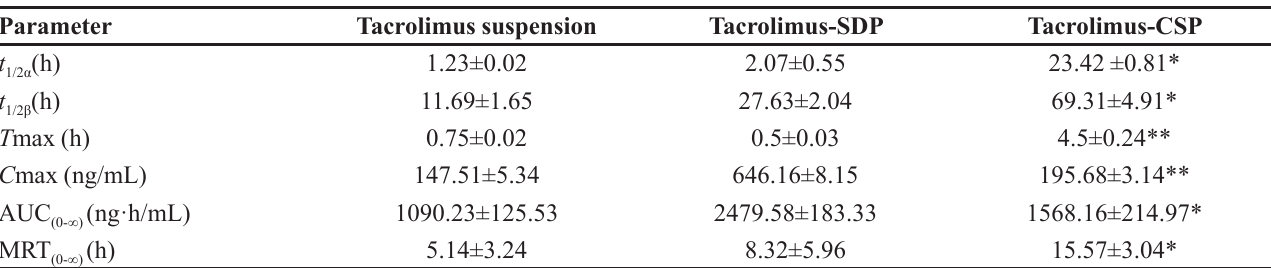
FIGURE 5 - Blood concentration–time curves of tacrolimus in rats.  :The blood tacrolimus concentration from tacrolimus suspension group.  : The blood tacrolimus concentration from tacrolimus-SDP group.  : The blood tacrolimus concentration from tacrolimus-CSP group. Data are presented as mean ± SD (n = 6). TABLE V - Pharmacokinetic parameters of tacrolimus suspension, tacrolimus-SDP, tacrolimus-CSP groups after oral administration to